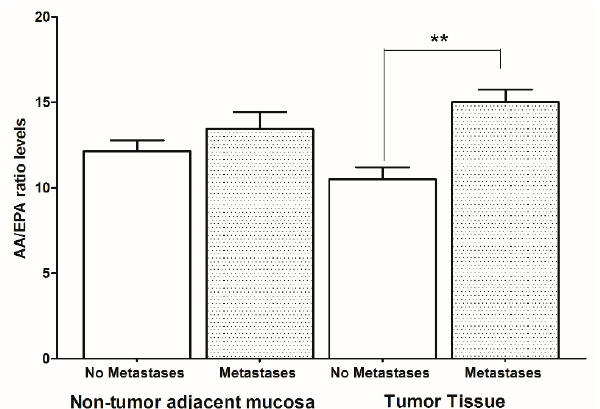
Figure 1. Arachidonic acid / eicosapentaenoic acid (AA / EPA) ratio levels in tumor tissue and non-tumor adjacent mucosa from colorectal cancer patients with and without metastases. Data are expressed as mean percentage ± SD. ** p < 0.02 (Analysis of variance (ANOVA and Tukey’s multiple comparison